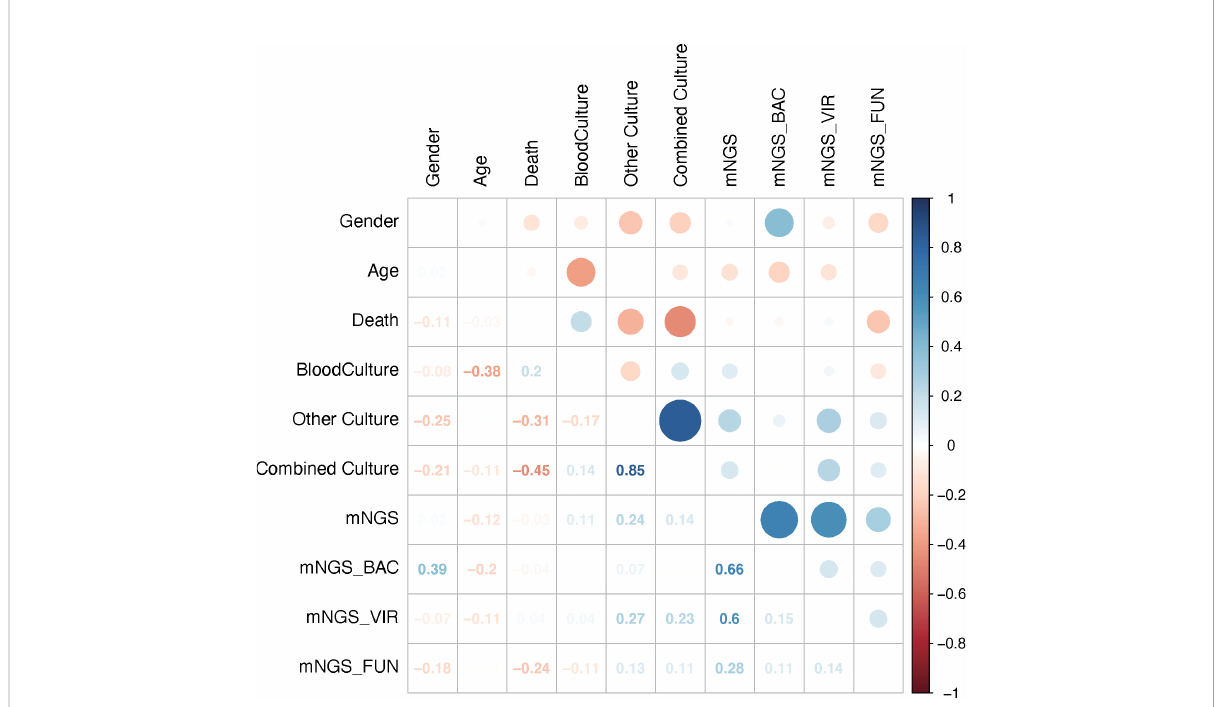
FIGURE 4 Results of mNGS were not correlated with those of conventional culture. The comparison of the mNGS with different cultured conditions. As shown, mNGS results had little correlation with blood or combined culture results. Correlation analysis. N = 27. mNGS, metagenomic next- generation